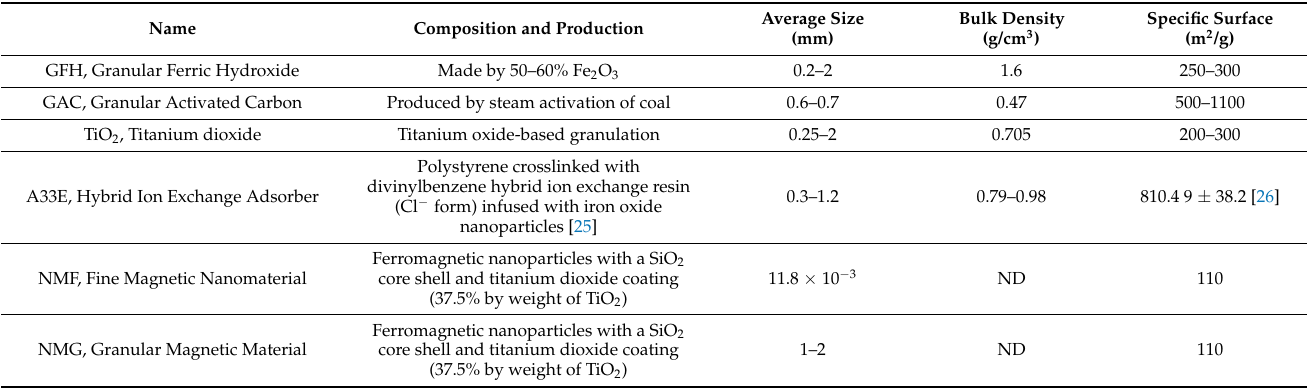
Table 1. Main characteristics of the investigated